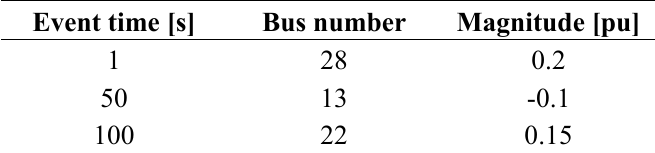
Table 2. Step load deviation